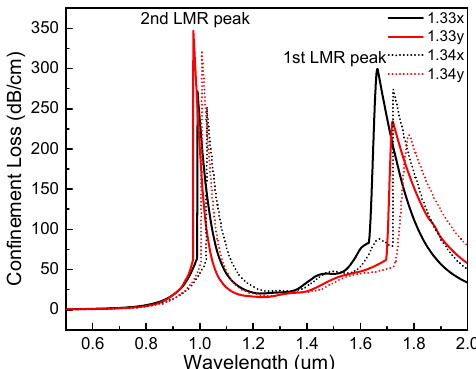
Figure 4. Loss spectra of x-polarized and y-polarized peaks at analyte RI n a from 1.33 to 1.34.